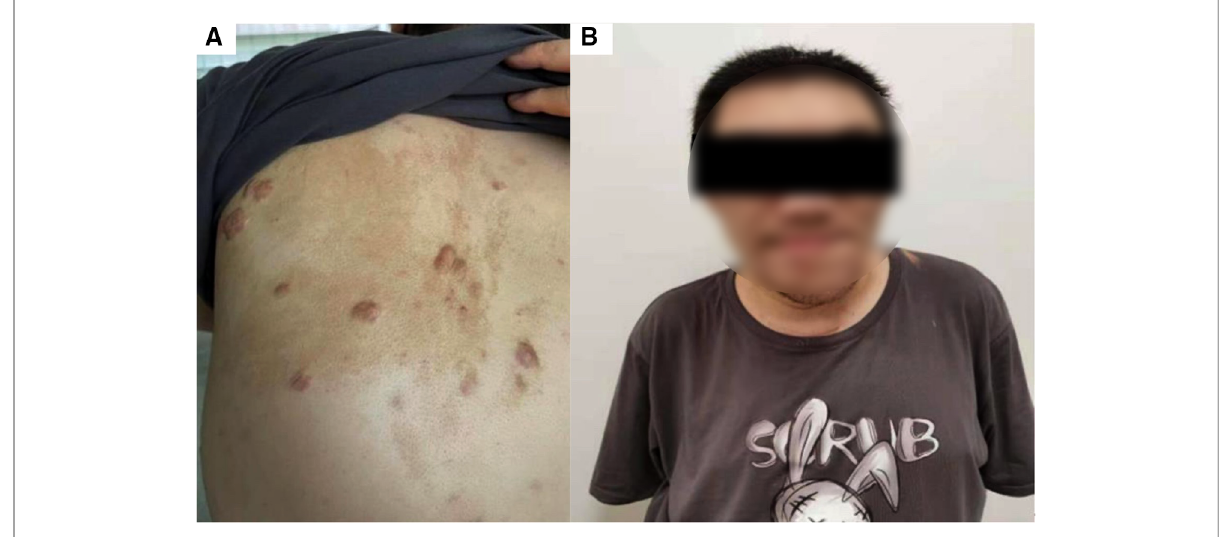
FIGURE 1 Representative images of the patient indicating McCune-Albright syndrome. Photographs of the back ( A ) from this patient demonstrates characteristic light brown pigmented birthmarks with jagged borders. These fl at patches occur around the midline of the back and are known as Café-au-lait spots. The appearance of the patient ’ s face ( B ) is indicative of a fi brous dysplasia